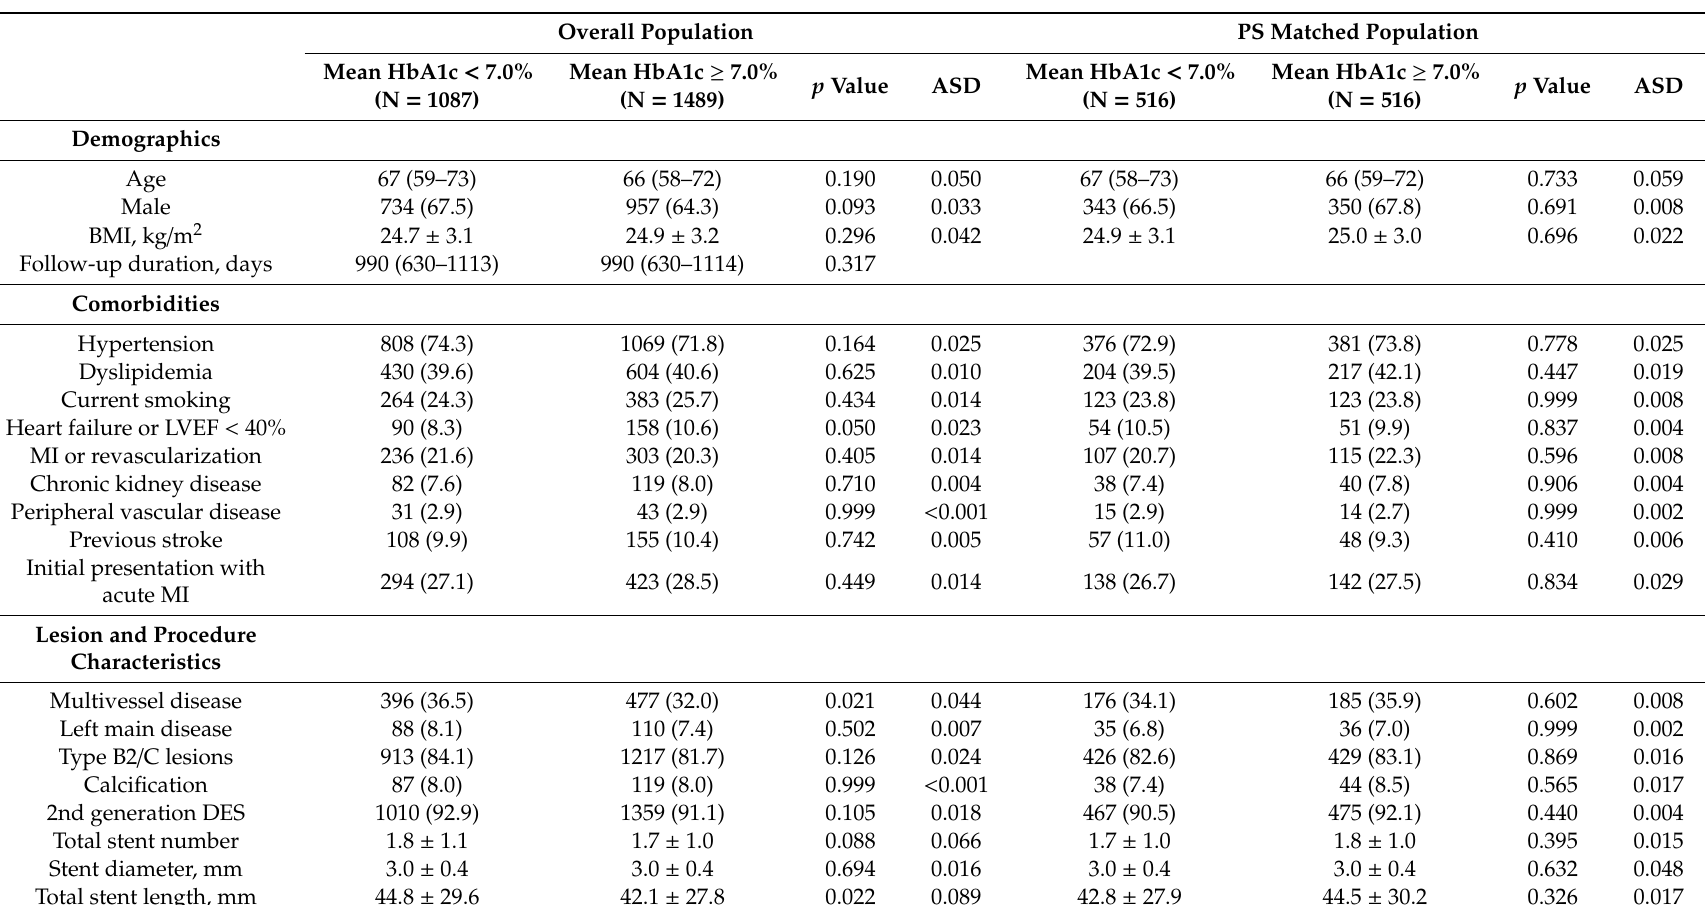
Table 1. Baseline characteristics of diabetic patients according to glycemic control based on HbA1c 7.0% during follow-up period after